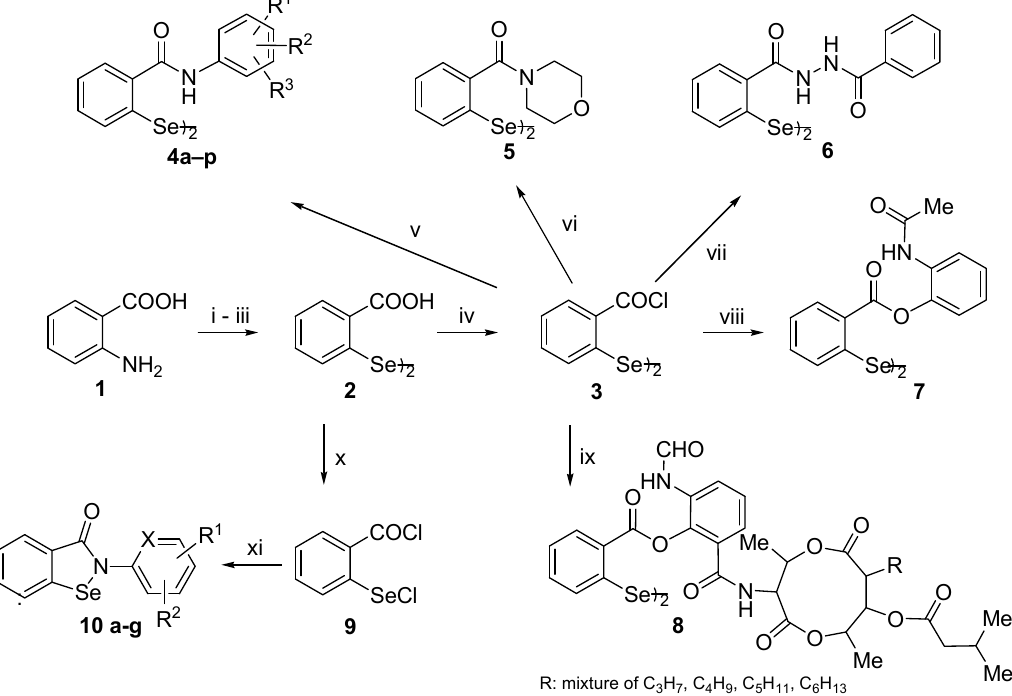
Table 1. Characteristics of compounds 4a – p , 5 – 8 , and 10a – g